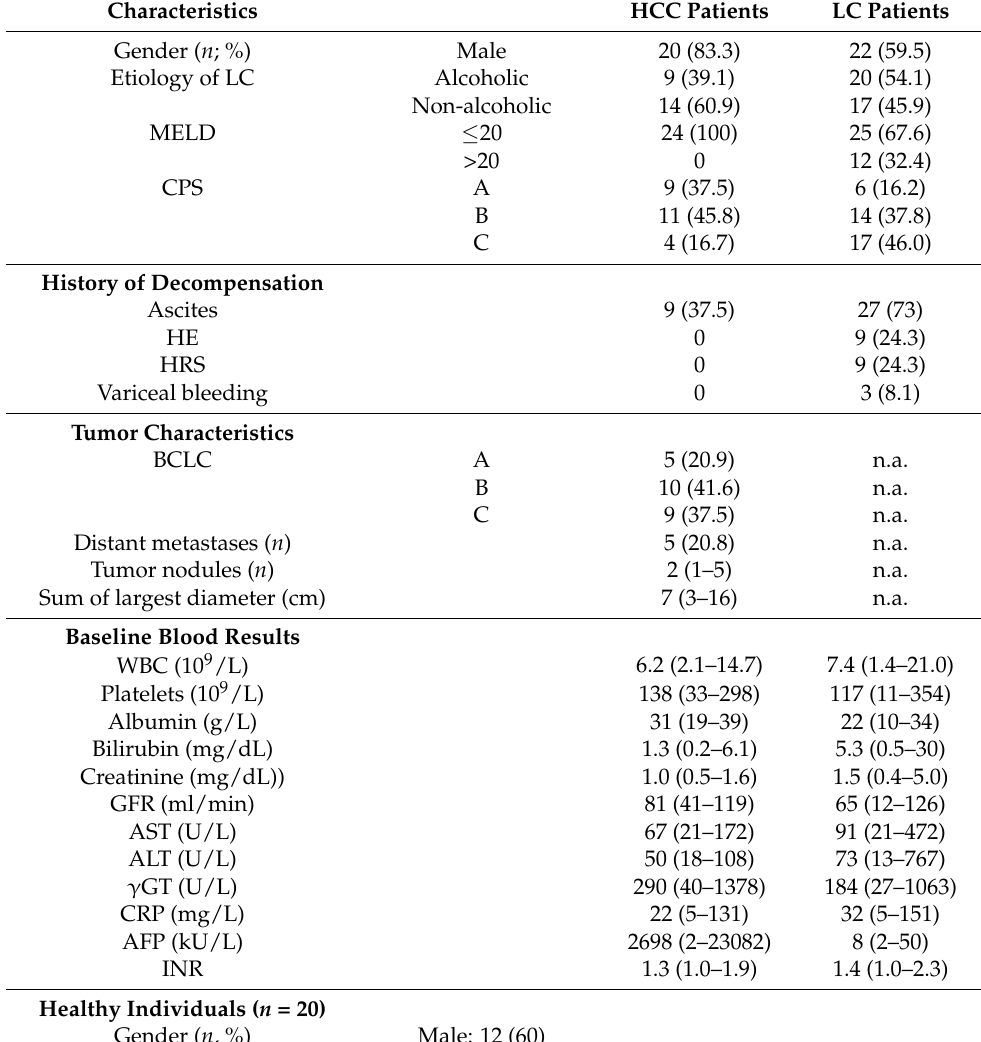
Table 1. Clinicopathological parameters of hepatocellular carcinoma (HCC) and liver cirrhosis (LC) patients (training cohort). The cohort included 24 HCC patients (median age: 65; range 44–79), 37 LC patients (59; 32–78) and 20 healthy